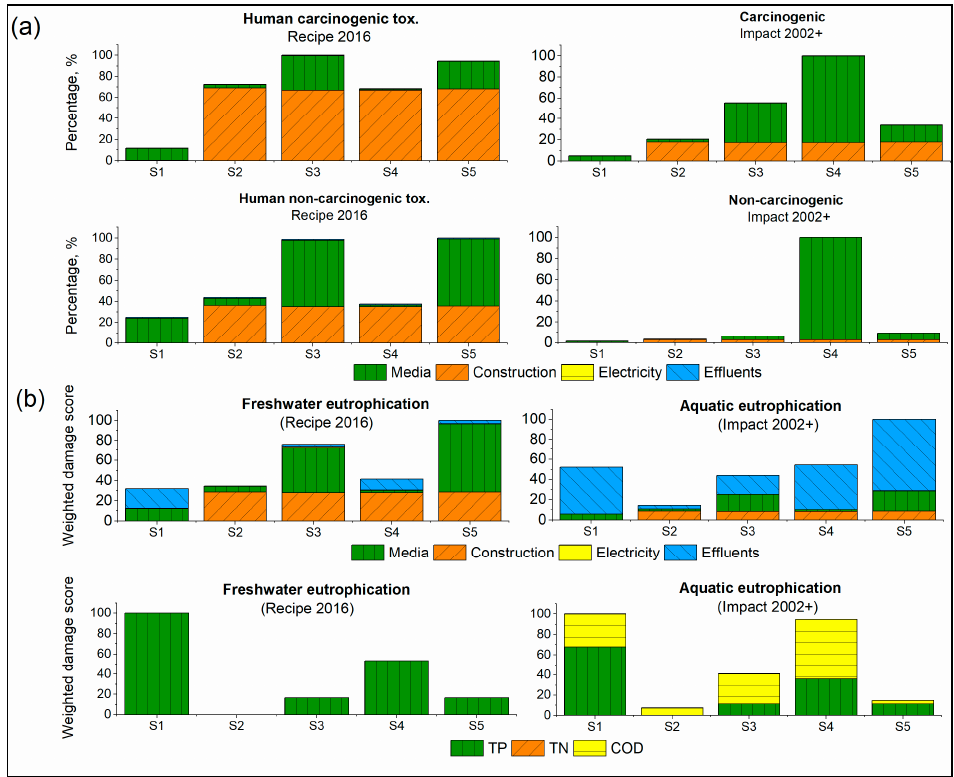
Figure 10. ( a , b ). Comparative scenario of the ReCiPe 2016 and Impact 2002+ methods on ( a ) human health categories; and ( b ) eutrophication.